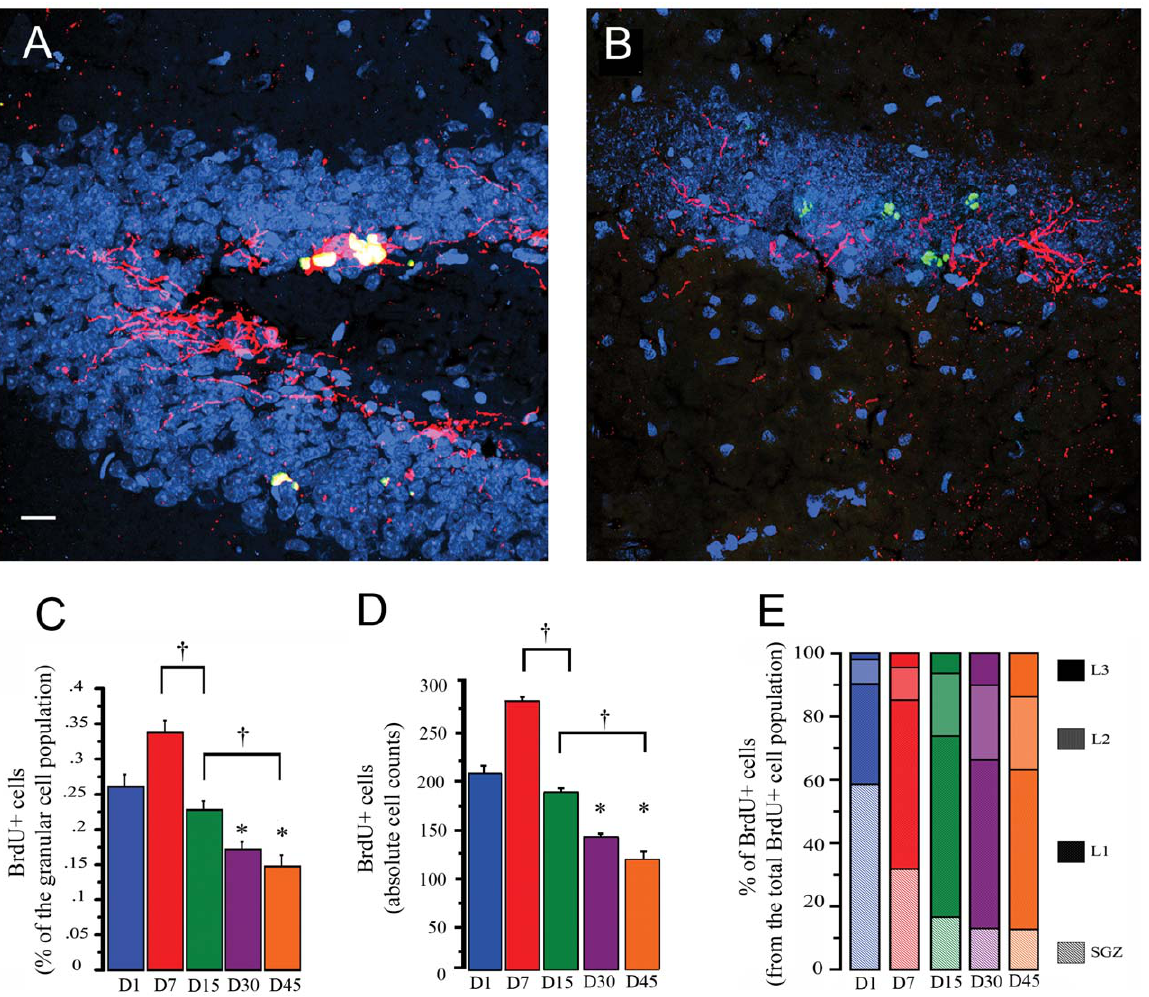
Figure 2. Survival and migration of adult-born granular cells. Confocal images, taken with a 25 6 objective, of the DG stained with DCX in red, BrdU in green, and counterstained with DAPI in blue. A) shows BrdU-positive cells co-localizing (yellow) with DCX from an animal sacrificed 7 days PBI; B) shows BrdU-positive cells from an animal sacrificed 45 days PBI that do not co-localize with DCX. C) Average proportion of BrdU-positive cells from the total granular cell population found in each (1, 7, 15, 30, and 45 days) PBI group. *P , 0.01 as compared to day 1 PBI group, { P , 0.01 between indicated groups. Note the significant decrease in the proportion of BrdU-positive cells found with time after new neurons were born. D) Absolute BrdU-positive cell counts found in each PBI group (1, 7, 15, 30 and 45 days); note that the results are very similar to the proportions shown in C. E) Percentage of BrdU-positive cells from the total BrdU-positive cell population found in each DG layer: the subgranular zone (SGZ), DG layer 1 (L1), DG layer 2 (L2), and DG layer 3 (L3), for the different PBI times. The different proportions of BrdU-positive cells found in the various layers with increasing time suggest that new cells migrate through the DG layers.